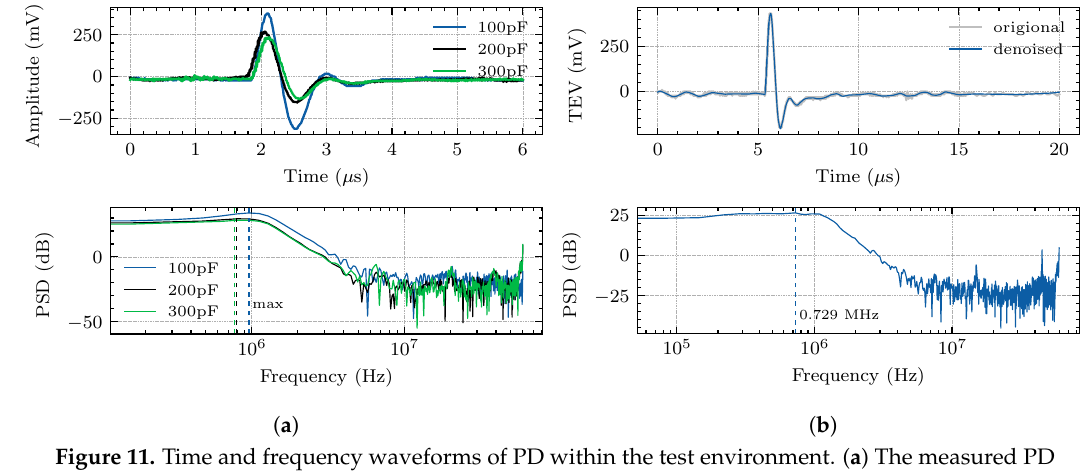
Figure 11. Time and frequency waveforms of PD within the test environment. ( a ) The measured PD waveforms and corresponding power spectral density (PSD) of different self-capacitance C 2 under laboratory conditions. ( b ) The time-resolved PD pulse waveform and its corresponding PSD measured by the designed TEV sensor